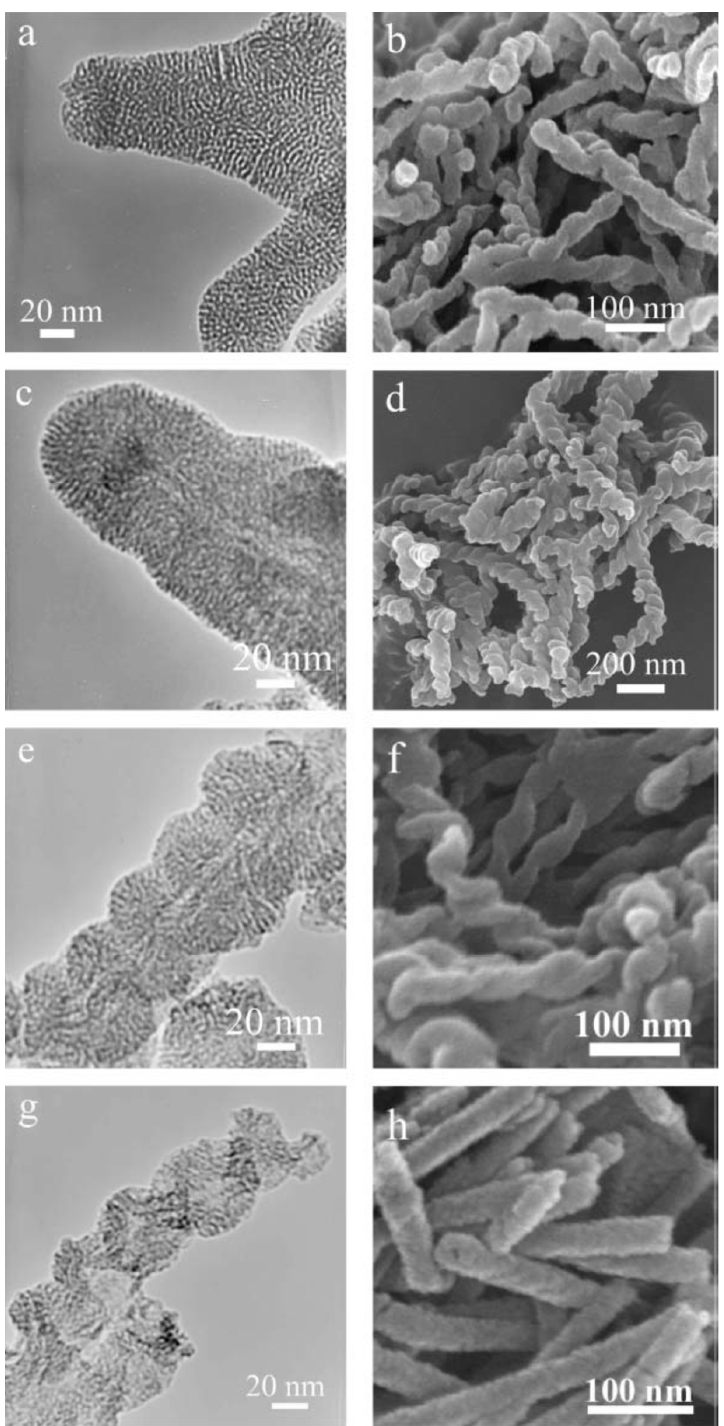
Figure 3. ( a ) TEM image of calcined mesoporous silica nanofibers (preparation condition: (10